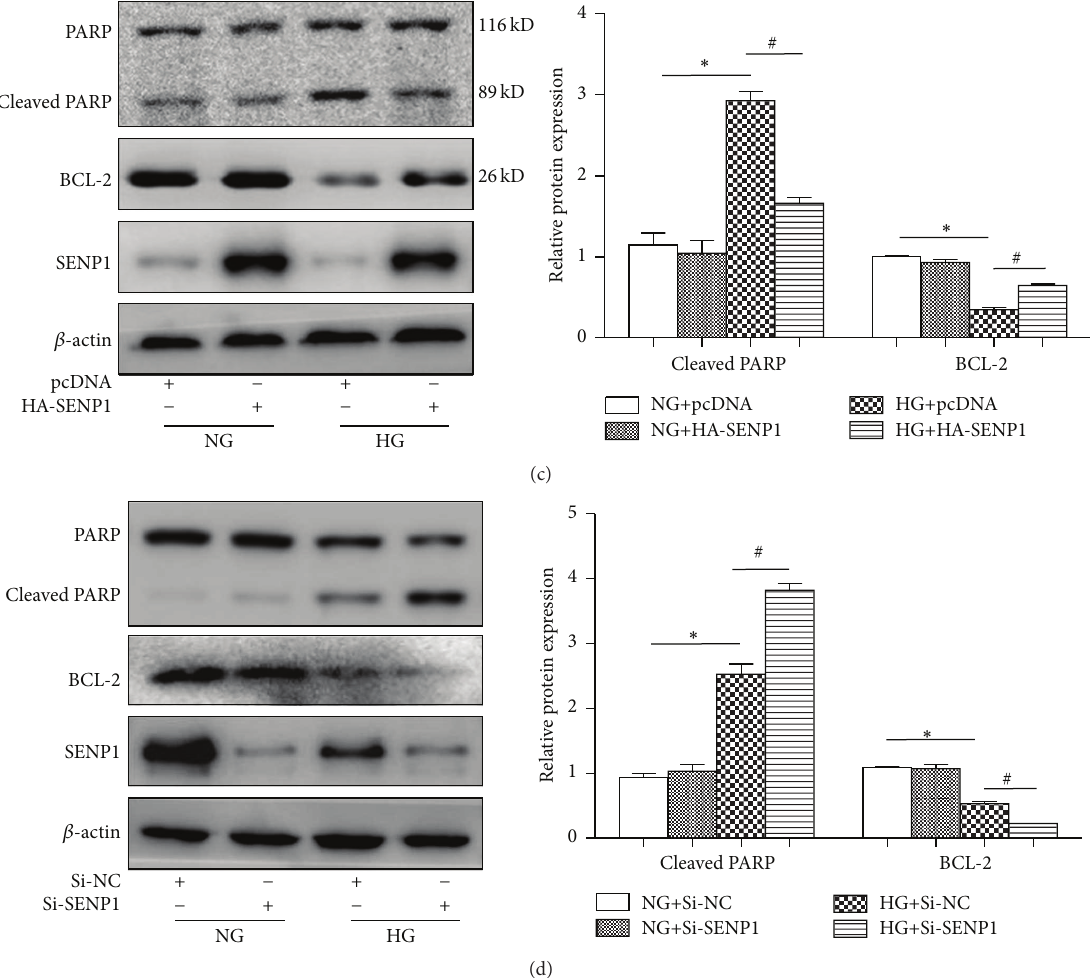
Figure 3: SENP1 played an antagonistic role in BRPC apoptosis under high glucose conditions. (a) Analysis of cellular apoptosis levels in the BRPCs treatment groups for 48 h: NG+pcDNA, NG+HA-SENP1, HG+pcDNA, and HG+HA-SENP1. (b) Analysis of cellular apoptosis levels in the BRPCs treatment groups for 48 h: NG+Si-NC, NG+Si-SENP1, HG+Si-NC, and HG+Si-SENP1. (c) SENP1, Cleaved PARP, and BCL-2 protein expression profiles in the four groups for 48h: NG+pcDNA, NG+HA-SENP1, HG+pcDNA, and HG+HA-SENP1. (d) SENP1, Cleaved PARP, and BCL-2 protein expression profiles in the four groups for 48 h: NG+Si-NC, NG+Si-SENP1, HG+Si-NC, and HG+Si-SENP1. Data are presented as their means ± SEM. Bars indicate SDs. ∗ 𝑃 < 0.05 versus NG+Si-NC or NG+pcDNA; # 𝑃 < 0.05 versus HG+Si-NC or HG+pcDNA; ∗∗ 𝑃 < 0.01 versus NG+pcDNA; ## 𝑃 < 0.01 versus